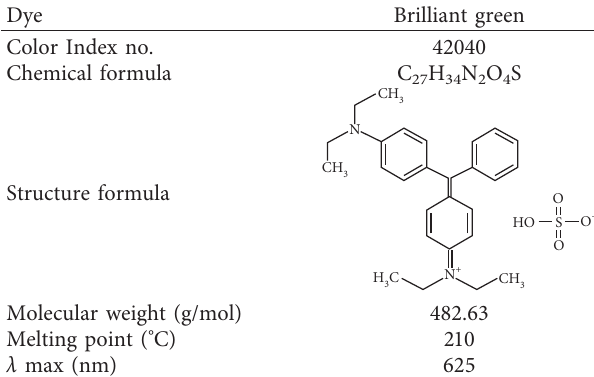
Table 1: Physicochemical characteristics of Brilliant green